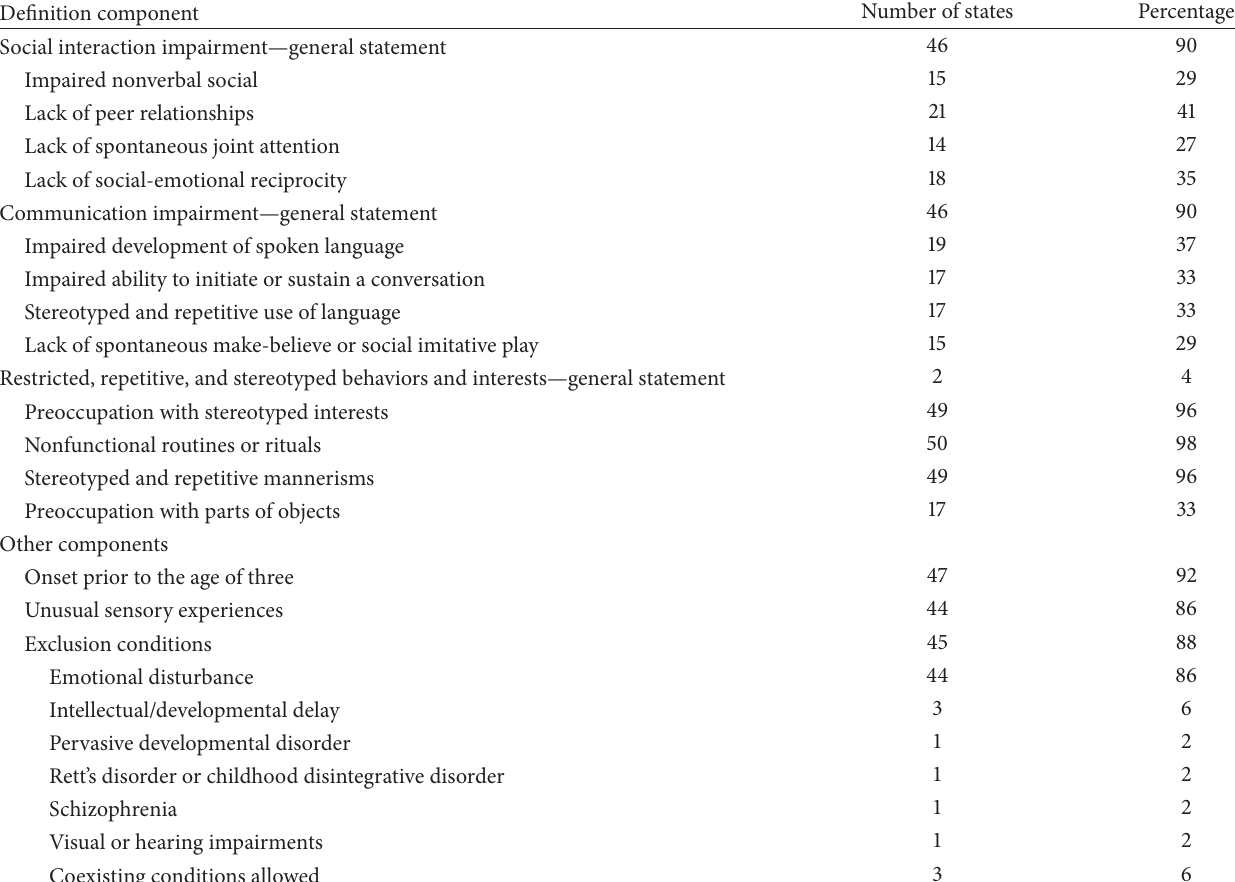
Table 1: Components of state education agency autism